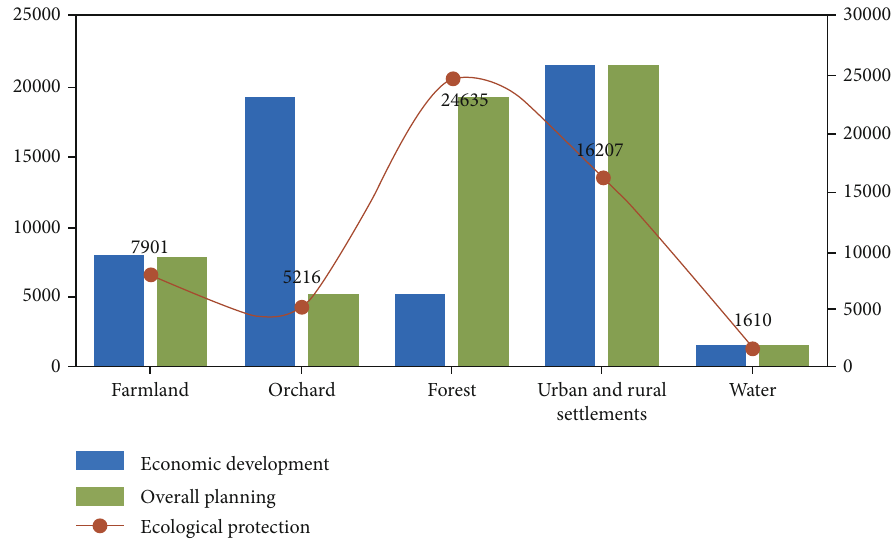
Figure 6: Optimization results of landscape area by scenario in